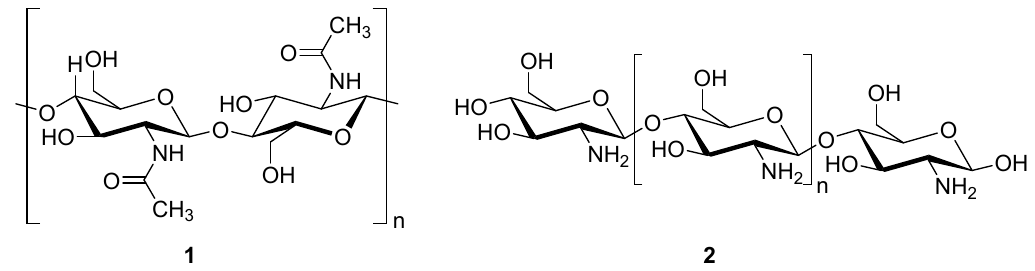
Figure 2. Chemical structures of chitin ( 1 ) and chitosan ( 2 ).